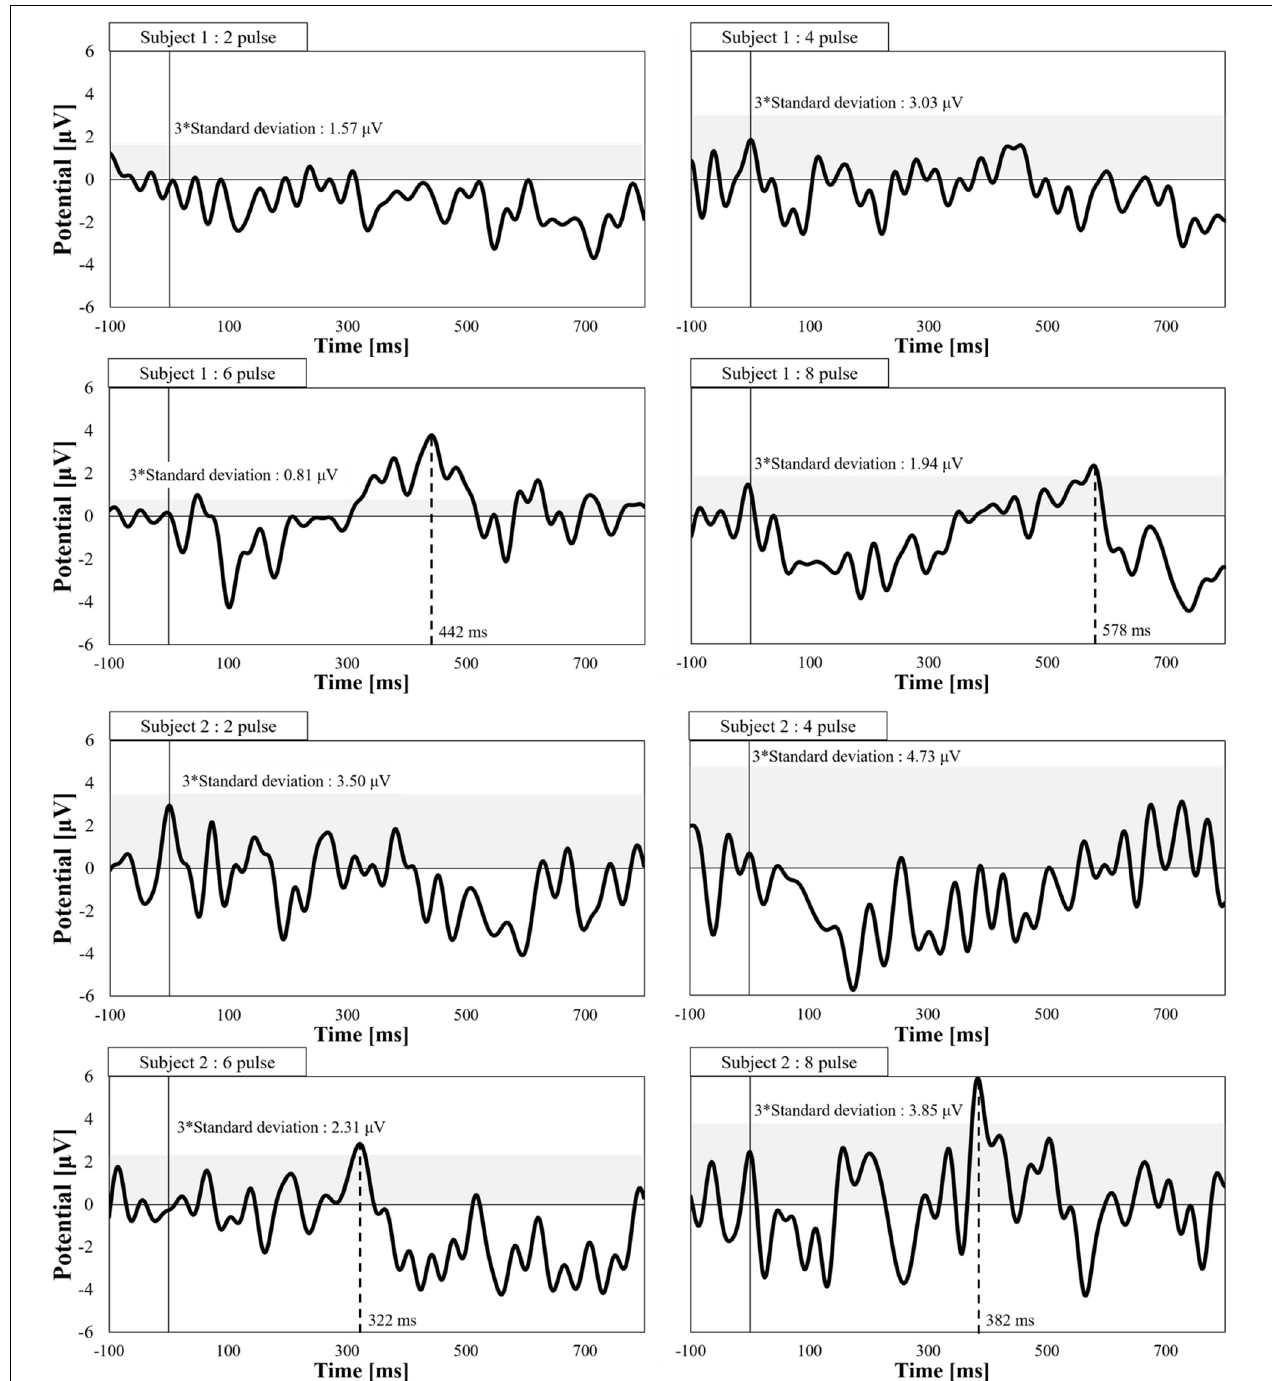
FIGURE 5 | Electroencephalogram waveforms of pain-related evoked potentials by a pulse-train electrical stimulation (frequency of 30 Hz and pulse width of 400 µ s, n = 2). The peak detection corresponds to values over three times the standard deviation of prestimulus time.